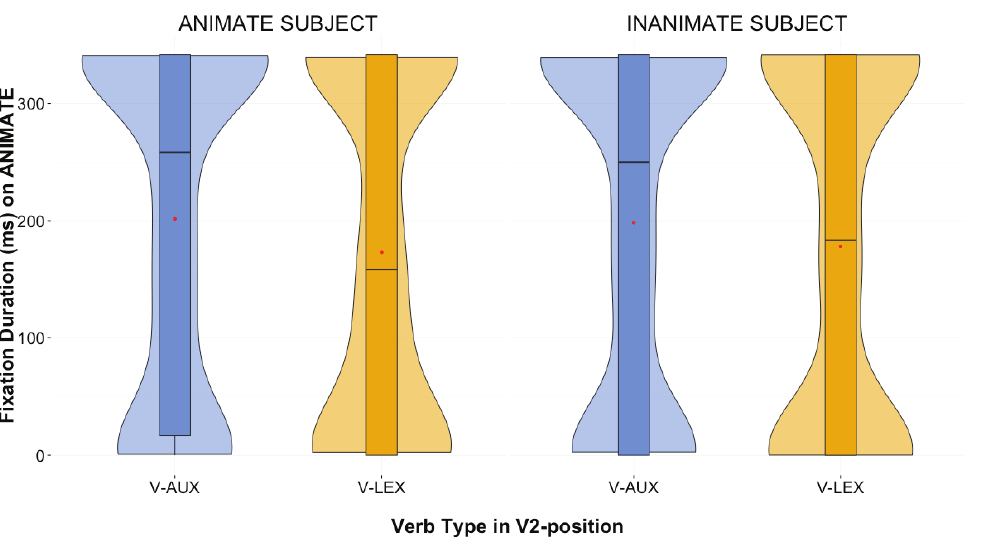
Figure 4: Violin/boxplot of fixation duration to the animate referent per condition in the pre-argument window. The red dot encodes the mean, the black vertical line encodes the median, the top and bottom edges of the box encode the interquartile range and the transparent beans provide a density plot. Note that the statistical analysis was performed on the logit-transfor- med odds ratio of fixations to the animate referent over those to the inanimate